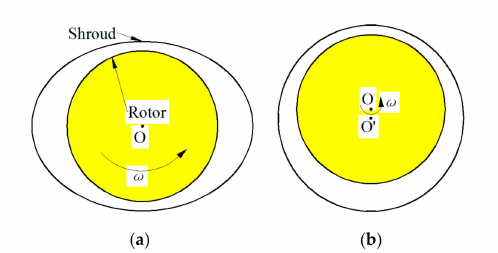
Figure 1. Static non-uniform tip clearance. ( a ) Ovalized casing; ( b ) eccentric rotor [4].